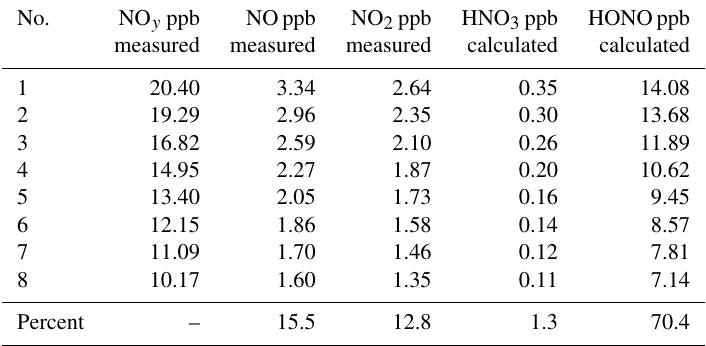
Table 1. Showing the distribution of NO y species NO, NO 2 , HNO 3 , and HONO produced from the HONO permeation source. No. NO y ppb NOppb NO 2 ppb HNO 3 ppb HONOppb measured measured measured calculated calculated 1 20.40